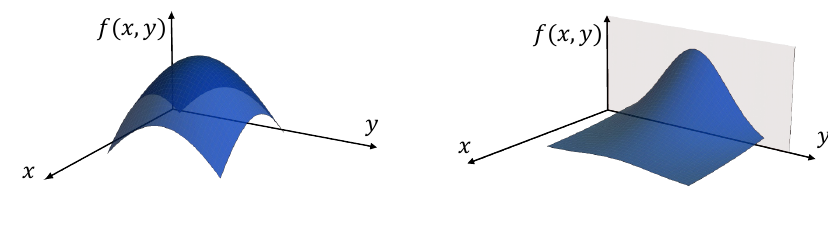
Figure 2 . The analog of multiple variables function for the local extremal points. When the maximal point is in the interior of definition domain, we require ∂ x f = ∂ y f = 0 , i.e. d f = 0 . However, it the maximal point locates at boundary of definition domain, we only needs ∂ y f = 0 but d f 6 = 0 in